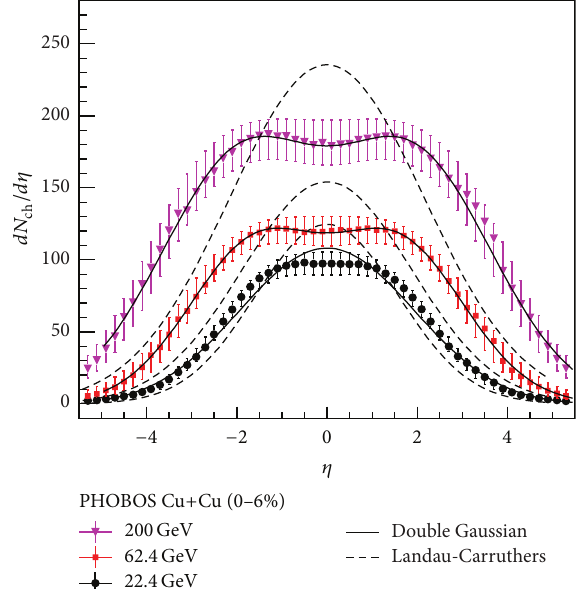
Figure 13: Factorization of RHIC and LHC data. The data points are fitted with various parametrized forms of (11).